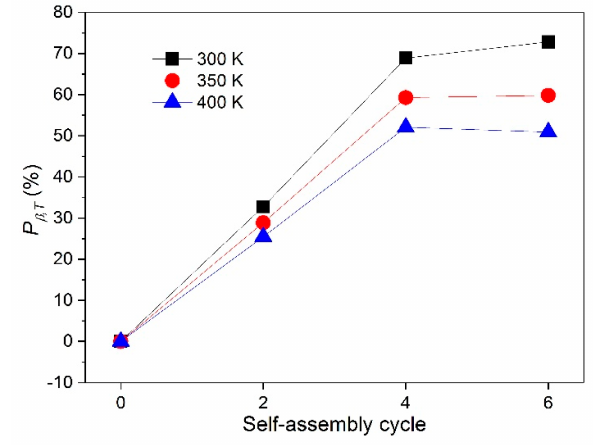
Figure 11. Increment percentage of Rosseland extinction coefficient.